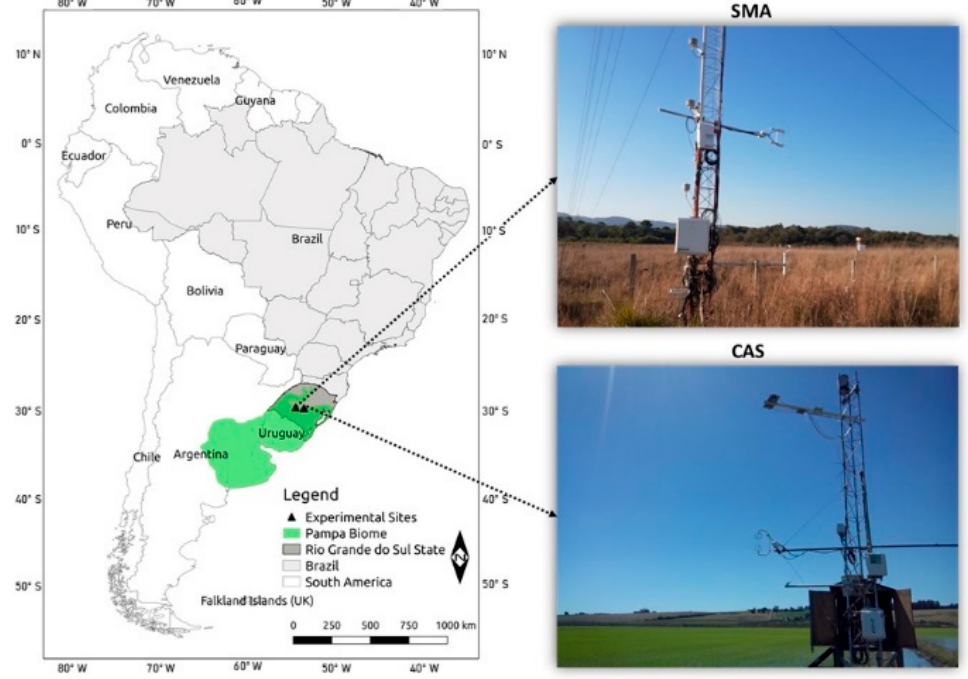
Figure 1. Location of experiment areas in the Pampa biome in southern Brazil—Santa Maria (SMA) and Cachoeira do Sul (CAS).